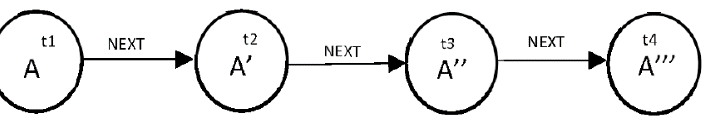
Figure 3. The first approach — adding a new value.